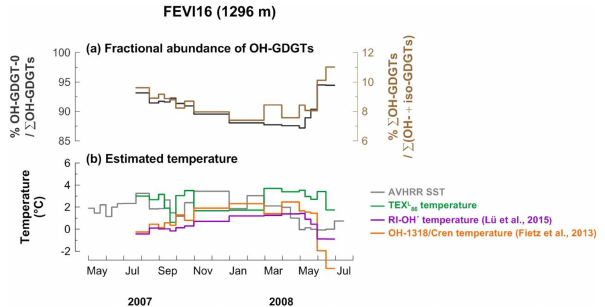
Figure 4. Changes in fractional abundance of OH-GDGTs (a) and estimated temperatures based on OH-related calibrations (b) at site FEVI16. The purple and orange lines indicate the calculated tem- peratures using the calibrations by Fietz et al. (2013) (Eq. 4) and Lü et al. (2015) (Eq. 6), respectively. The green line indicates the TEX L -derived 86